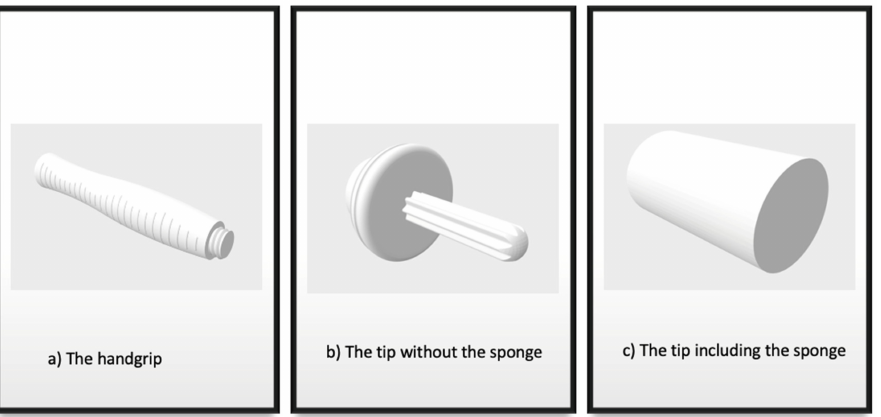
Figure 2. Three dimensional drawings of the device